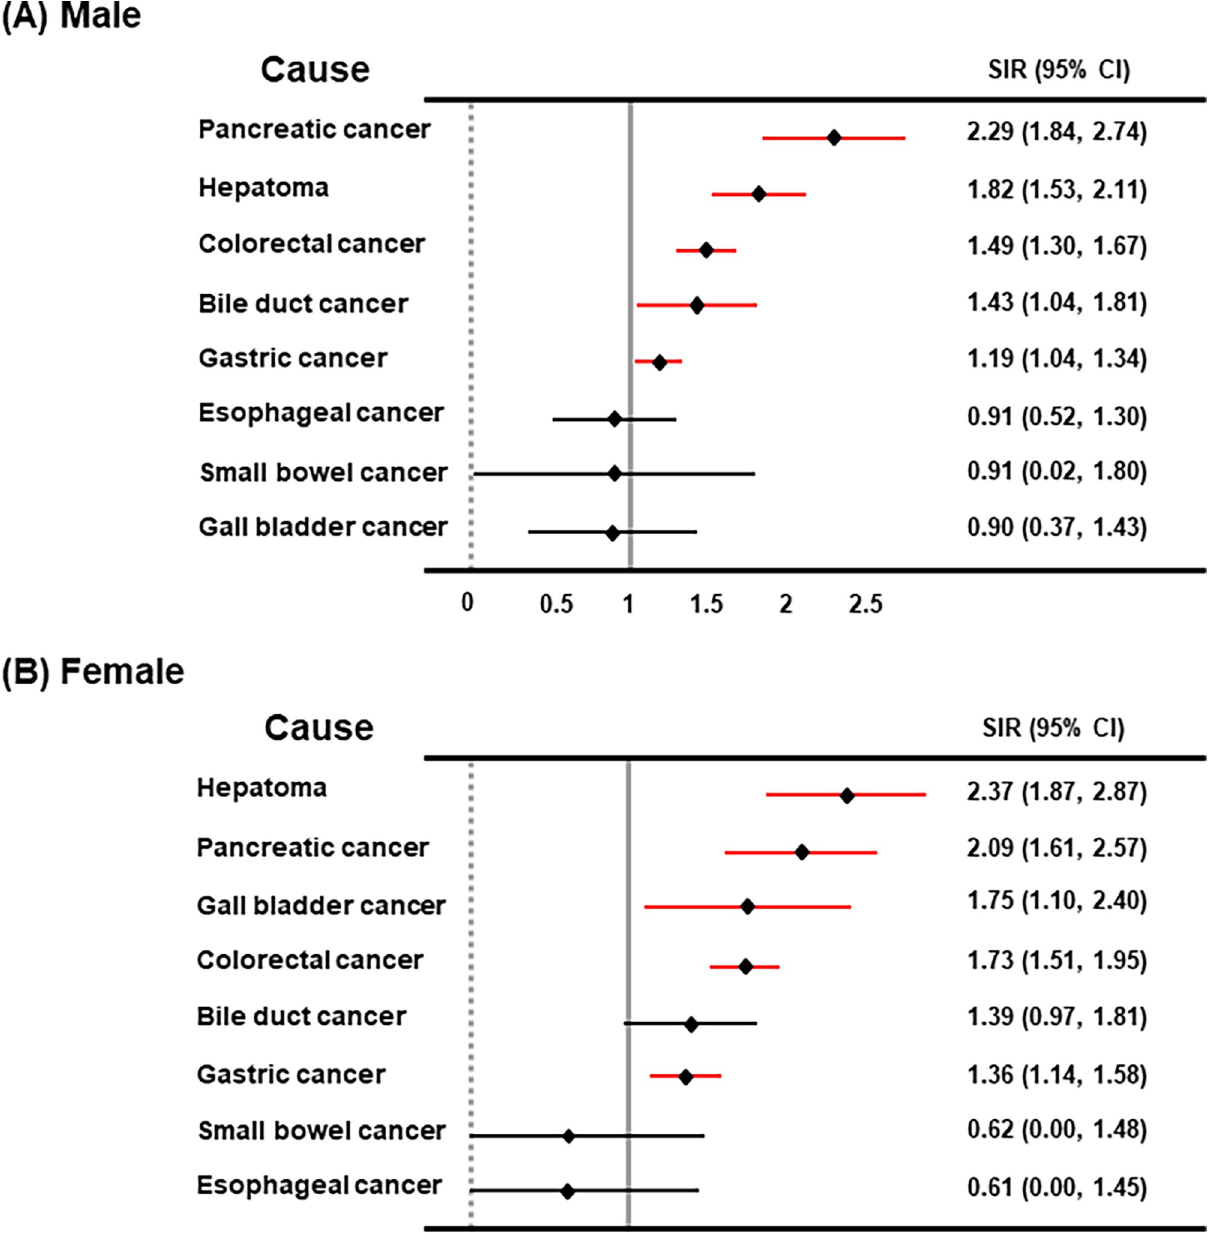
Fig 1. Standardized incidence ratio of digestive cancer in pre-dialytic CKD patients compared with the cohort population (men and women). Abbreviations: CKD, chronic kidney disease; No, number; SIR, standardized incidence rate; CI, confidence interval.